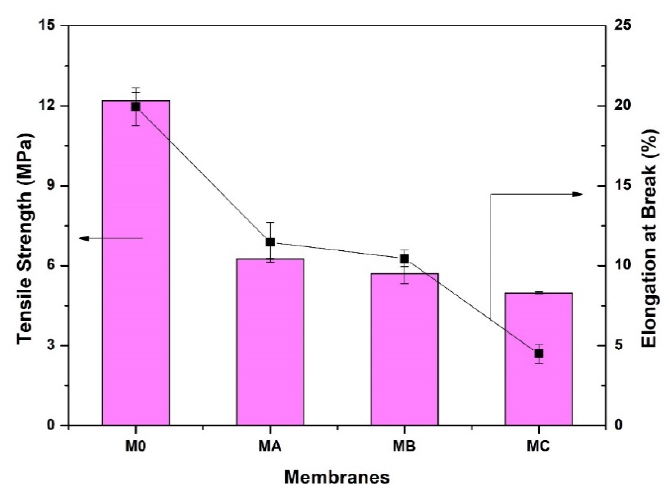
Figure 7. Effects of dopamine addition on mechanical properties of the membranes.